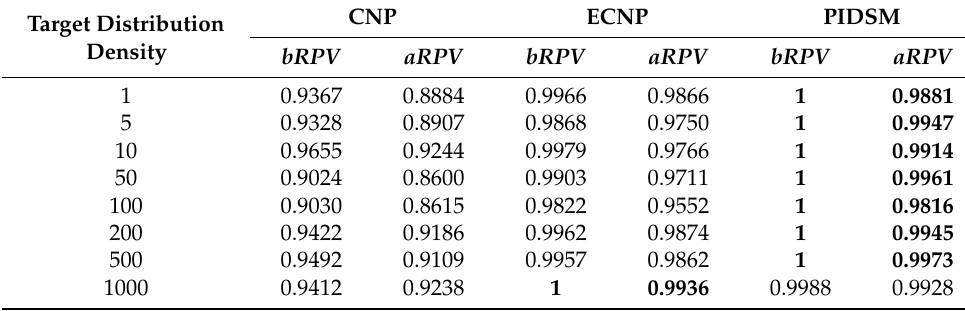
Table 9. Comparison results of different target distribution